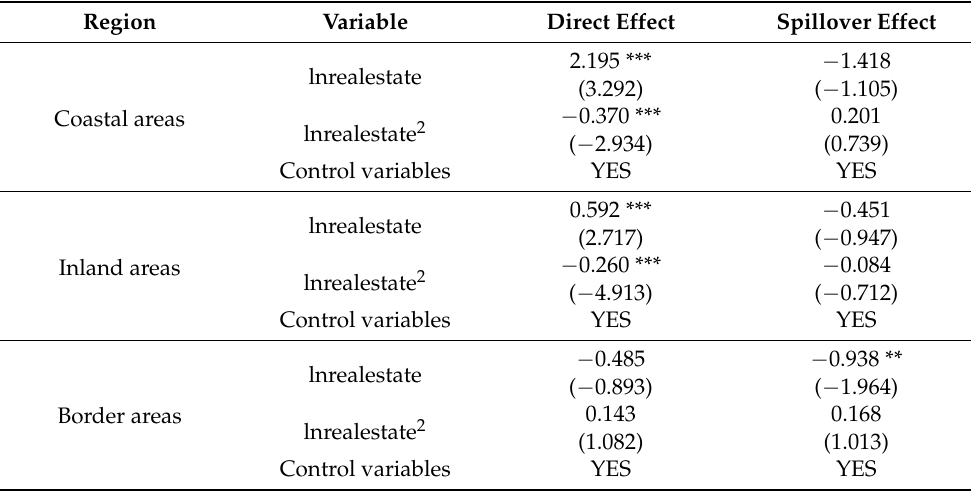
Table 6. Regression results of SDM in each